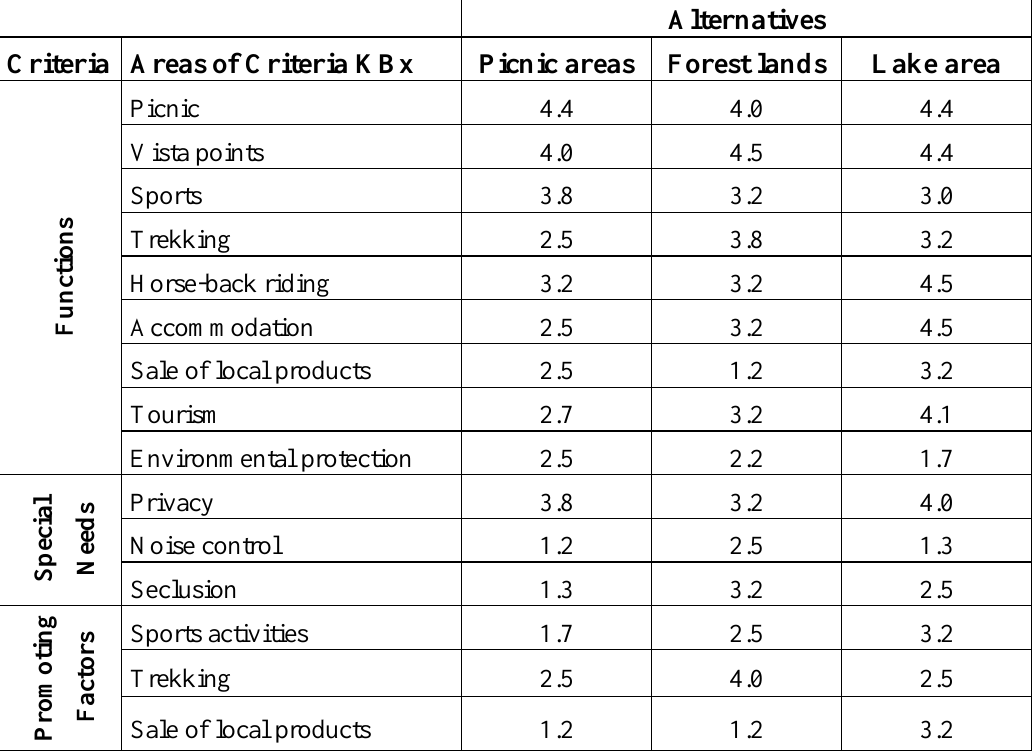
Table 3. Summary for goal-value matrix of the BLANP open space.